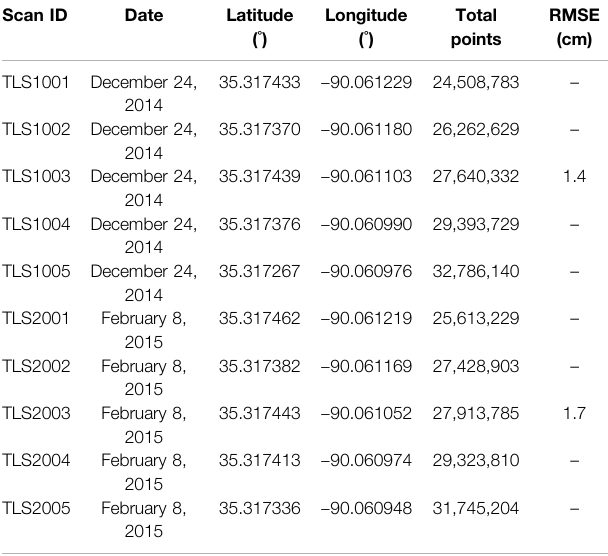
TABLE 1 | The information for the fi ve TLS scans collected in an active gully in Meeman-Shelby Forest State Park in Shebly County, Tennessee,